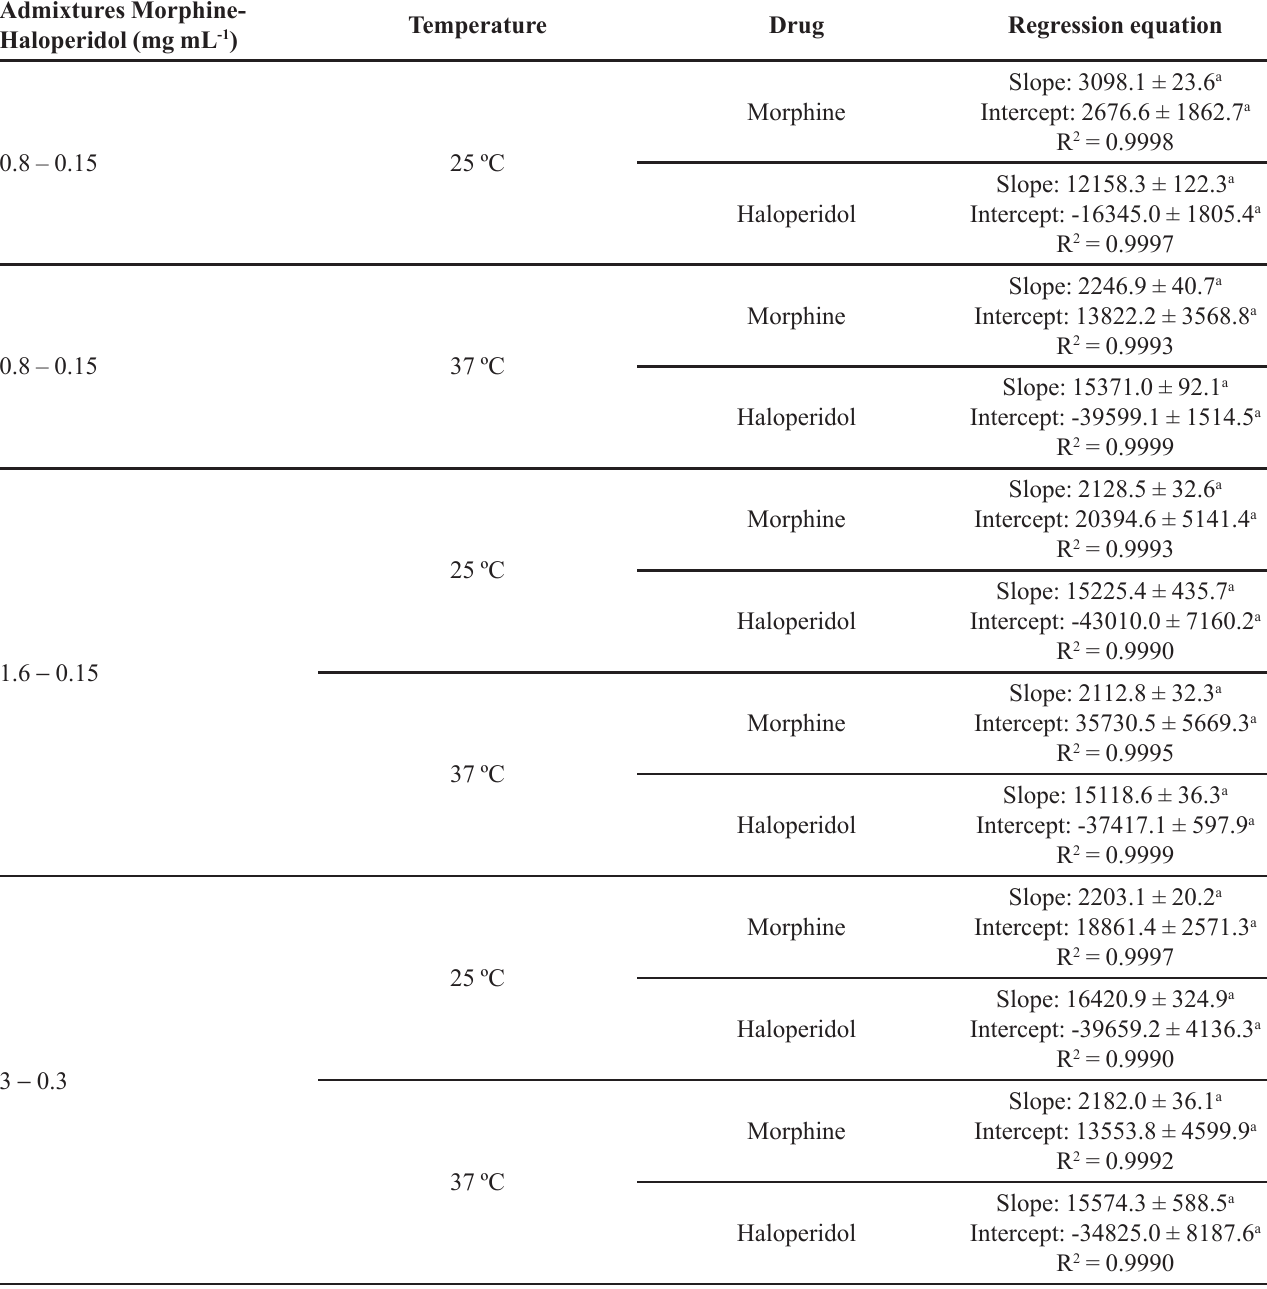
TABLE II - Regression equations for admixtures Admixtures Morphine- Haloperidol (mg mL -1